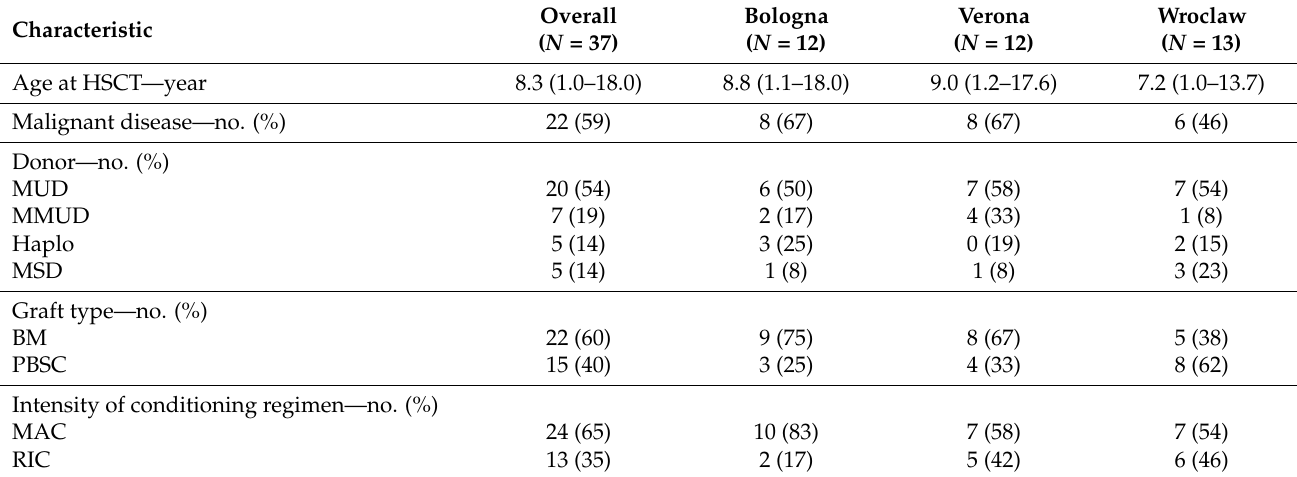
Table 1. Clinical and transplant characteristics of enrolled patients. Data are shown for the whole cohort and for each of the three pediatric centers. BM: Bone marrow; MAC: Myeloablative condition- ing; MMUD: Mismatched unrelated donor; MSD: Matched sibling donor; MUD: Matched unrelated donor; PBSC: Peripheral blood stem cells; RIC: Reduced intensity conditioning.